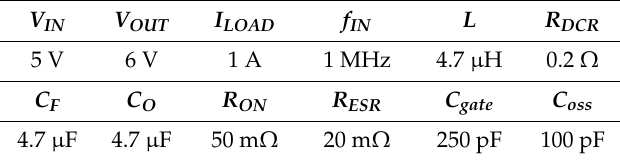
Table 2. Simulation conditions for buck-boost converter with ETM.